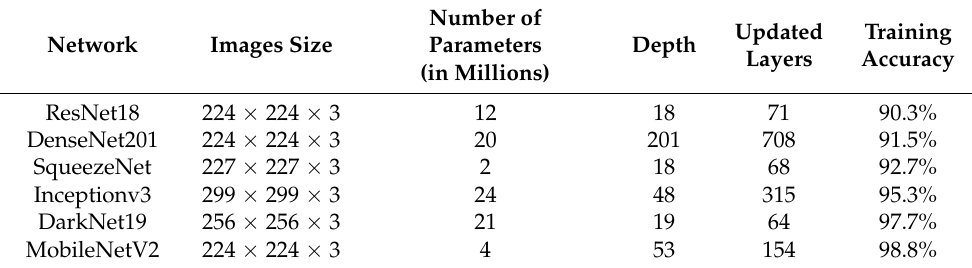
Table 7. Performance comparison of various pre-trained models on brain MRI dataset.